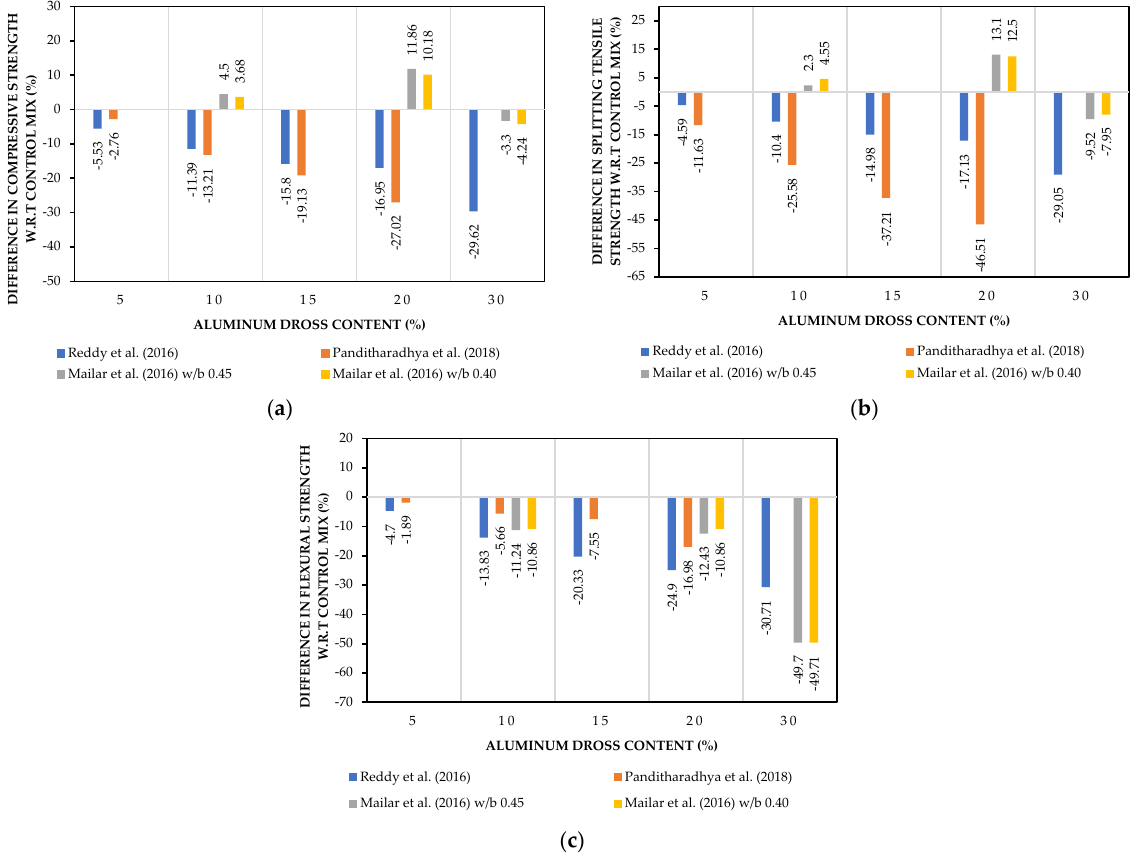
Figure 2. Variation in ( a ) compressive strength, ( b ) splitting tensile strength and ( c ) flexural strength of concrete incorporating different aluminum dross contents (data from ref. Mailar et al. [122], Reddy et al. [131] and Panditharadhya et al. [132].